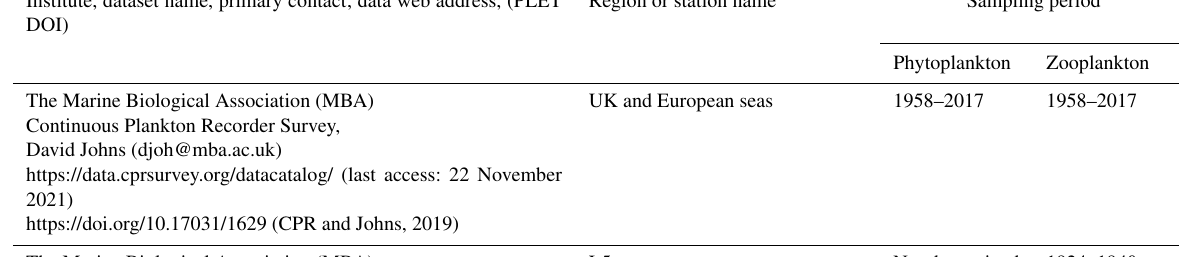
Table 1. Plankton data currently held in PLET and used to produce the aggregated lifeform outputs. For un-aggregated plankton data, contact information and institute-specific data holdings (where available) are given for each data institute. Most of these time series are ongoing, and many sample at higher temporal resolution than the monthly average data held in PLET. Prospective users for these higher-resolution versions of the respective time series are encouraged to consult with the contact people listed